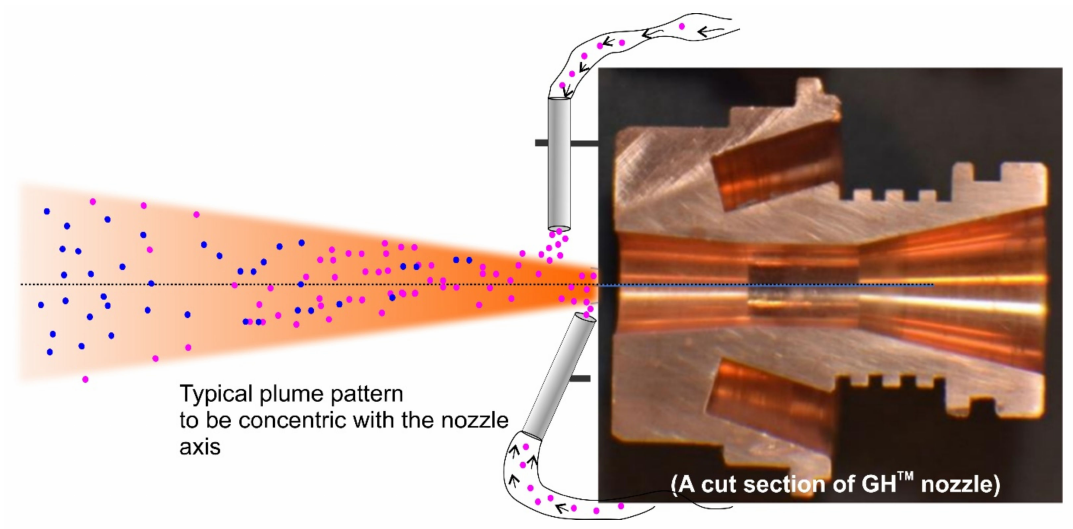
Figure 9. Impingement of a particle with a 90 ◦ injector vs. a 75 ◦ injector. Chances of improving the residence time of the particle in the plume with a 75 ◦ injector (author’s own